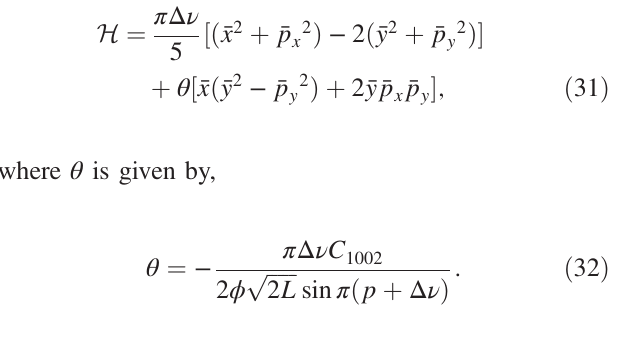
FIG. 14. Comparison of the dynamic apertures between the theory (blue solid and black dashed lines) and the tracking (red cross) at a vicinity of the sum resonance: ν